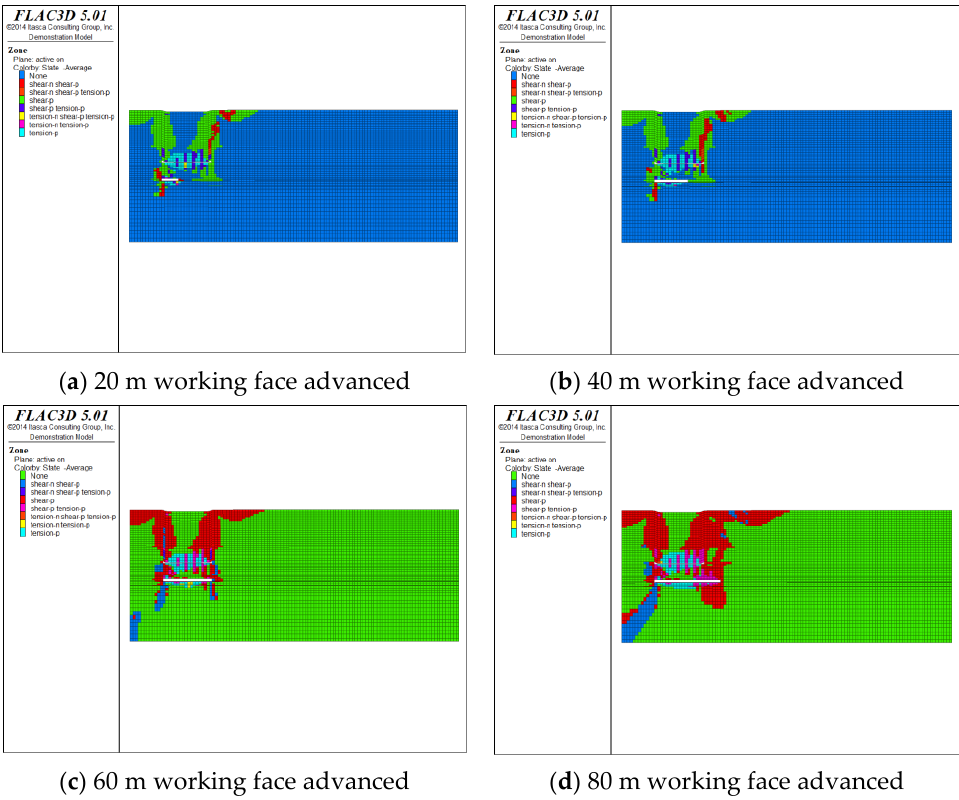
Figure 8. Nephogram of the plastic zones below the goaf.